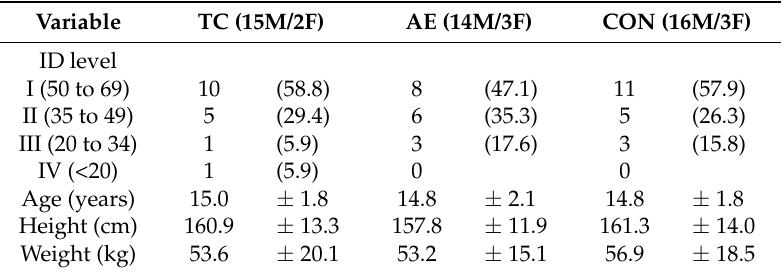
Table 1. Baseline parameters for